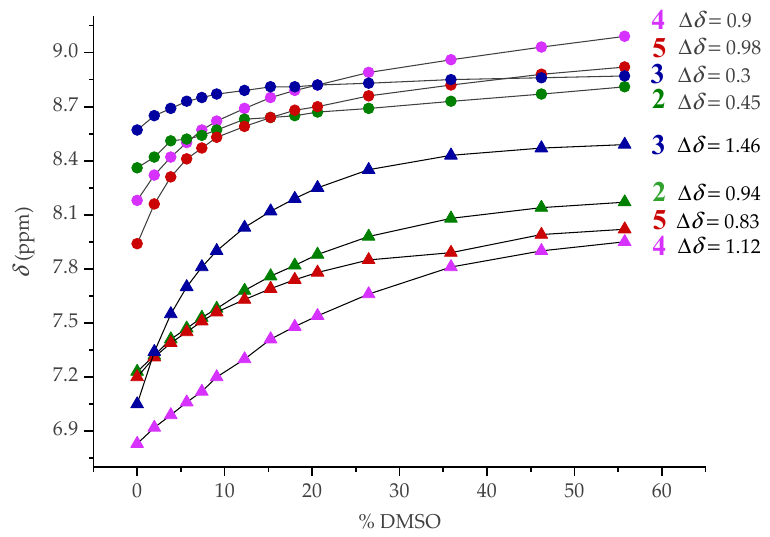
Figure 9. Solvent dependence of of NH Fn ( • ) and NH Ala ( ▲ ) chemical shifts of peptides 2 – 5 at increasing concentrations of d 6 -DMSO in CDCl 3 ( c = 25 mM, 298 K) to probe exposed vs. hydrogen- bonded amides.